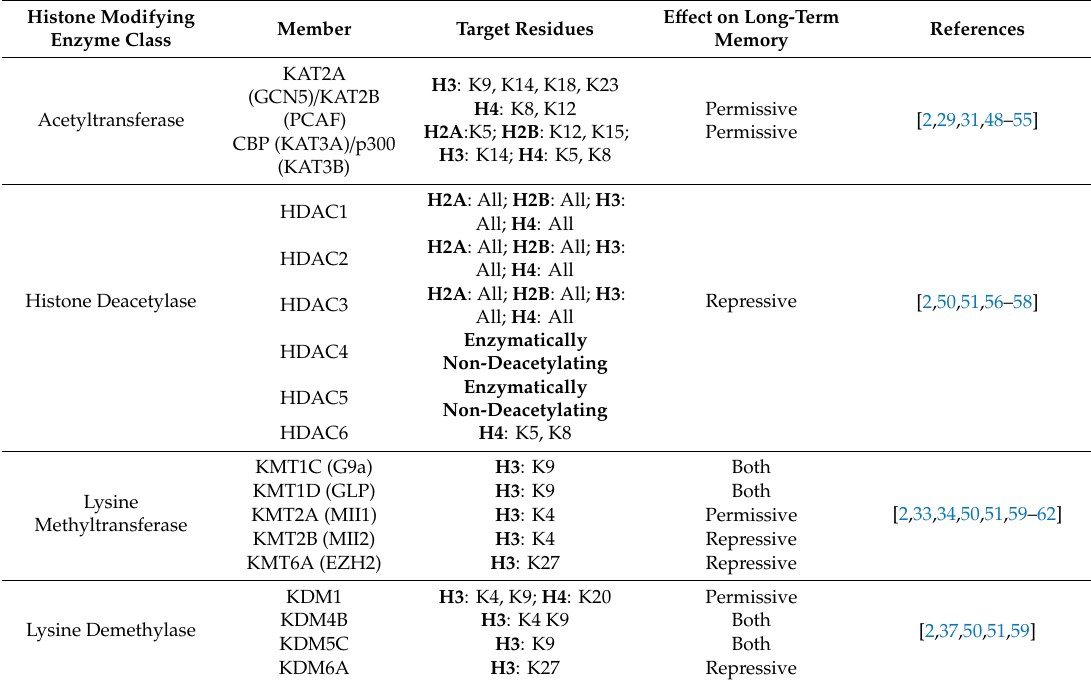
Table 1. Histone modifying enzymes regulate long-term